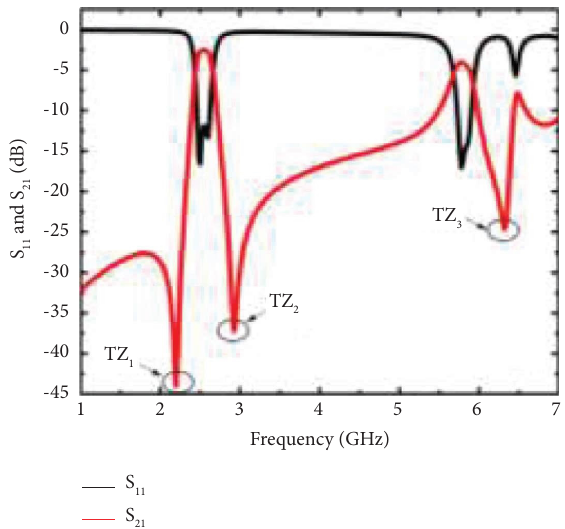
Figure 4: Simulation of S 11 and S 21 of the proposed resonator.